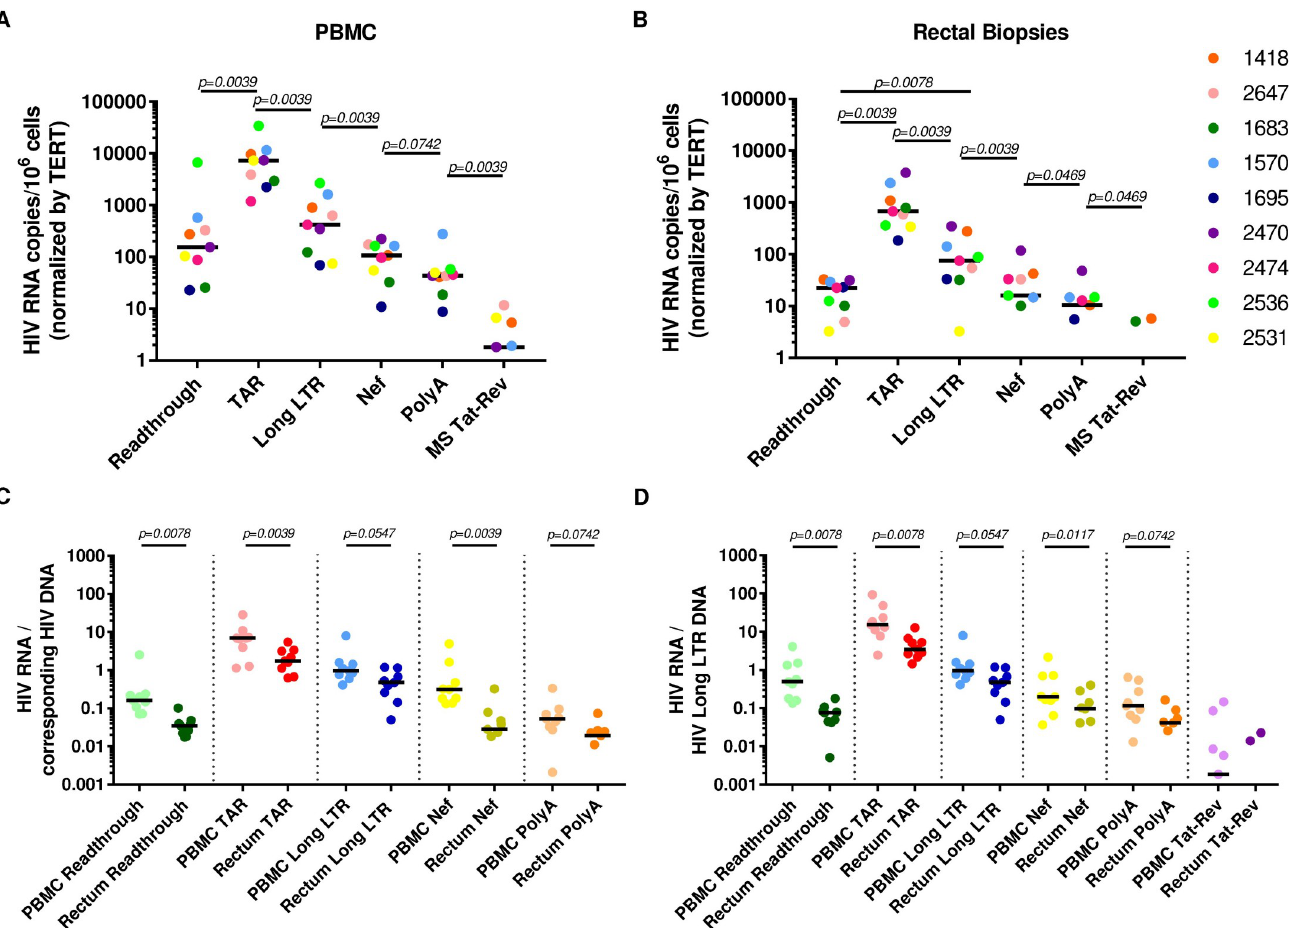
Fig 2. HIV RNA levels and HIV RNA/DNA ratios reveal blocks to elongation, distal transcription, and multiple-splicing in PBMCs and intact gut biopsies. Read-through, total (TAR), 5’ elongated (R-U5/pre-Gag; “Long LTR”), Nef, polyadenylated (PolyA), and multiply-spliced Tat-Rev (MS Tat-Rev) HIV RNAs were measured in (A) PBMCs; and (B) intact rectal biopsies ( n = 9 ART-suppressed individuals). 2C-D: Levels of HIV transcription per provirus are lower in the gut than the blood. Levels of each HIV RNA were normalized to HIV DNA from the same sample as measured by (C) ddPCR for the corresponding DNA sequence region (PolyA was normalized to the Read-through assay, which employs the same forward primer/probe), except for MS Tat-Rev where there is no DNA equivalent; or (D) ddPCR for the Long LTR assay, which is present once in each intact provirus. Bars indicate the median. Comparisons between transcripts were performed using the Wilcoxon signed-rank